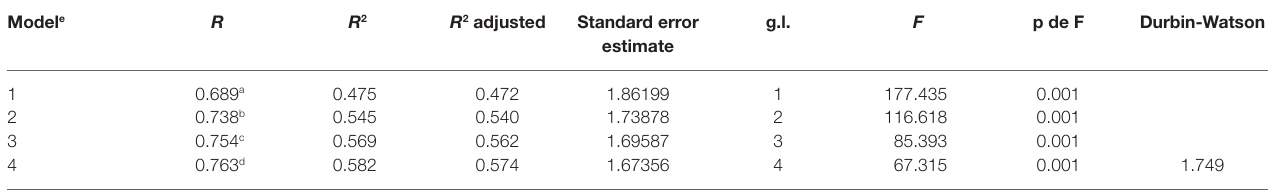
TABLE 1 | Stepwise Multiple Linear Regression Model.